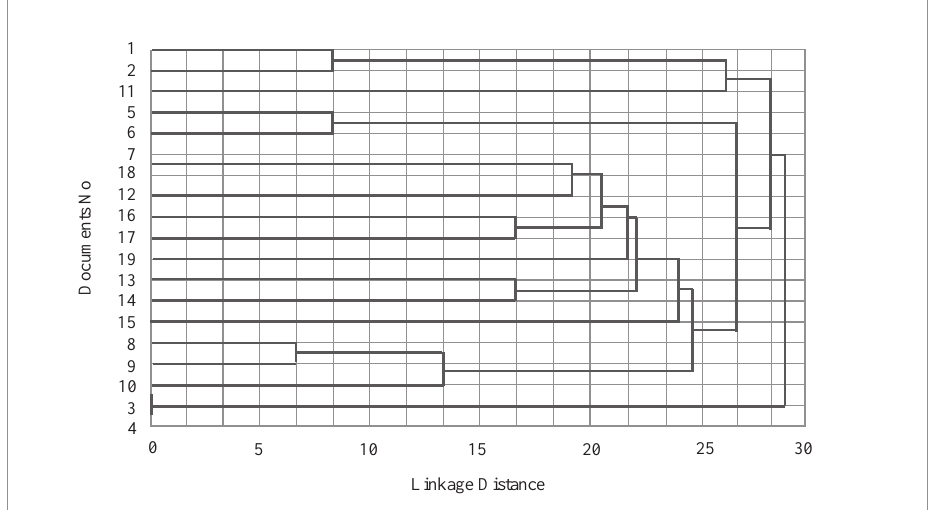
Fig. 9. Hierarchical tree diagram